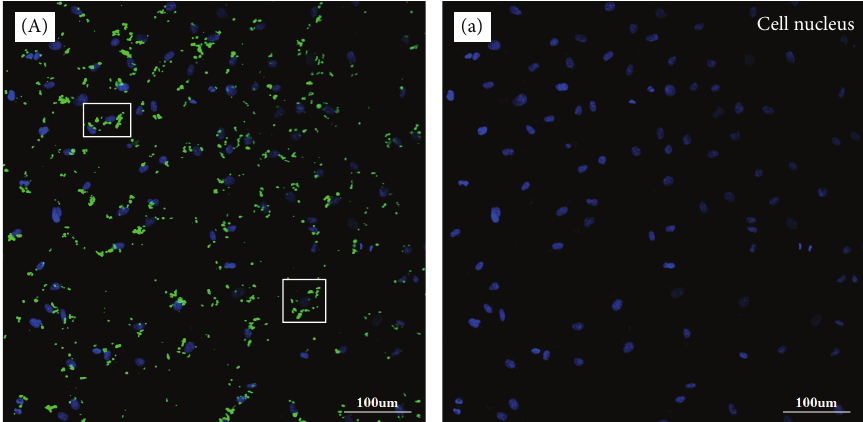
Figure 5: Confocal images of EA926 cells after incubating with ASF microparticles (green) for 2h. (A) Overlay; (a) cell nucleus (blue).